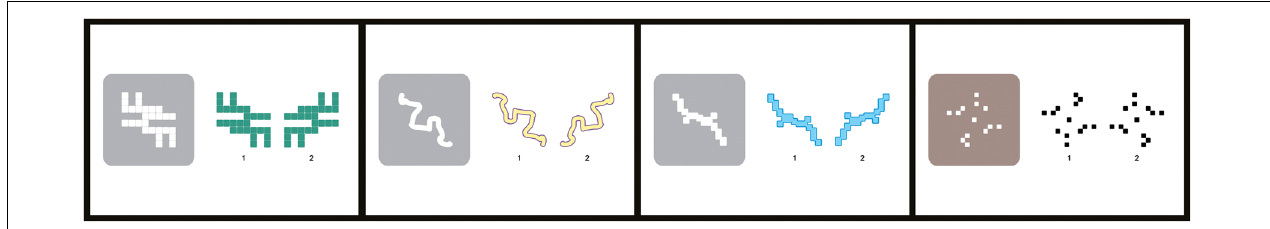
FIGURE 1 | Example items from the Mental Rotation Training Program (MRTP). In all examples, the first stimulus is rotated 180 ◦ and the second stimulus is flipped over the X axis with respect to the target.